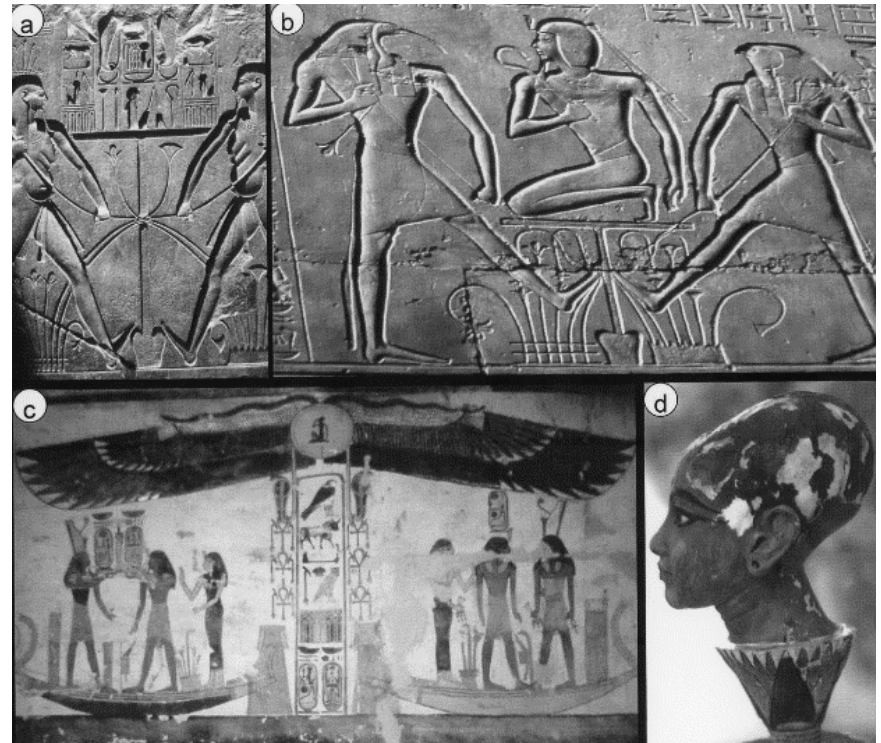
Figure 4. Union symbol (sema-taui) and ankh. ( a ) The cartouche of Ramesses II replaces a lotus flower on the central shaft of the sema-taui motif in Thebes. Twin gods (Hapy figures) that personify the floodwaters of the Nile River grasp the lotus and papyrus stems to support the axis mundi. Luxor, 13th c. BCE. ( b ) A kneeling image of Ramesses II replaces the sema-taui’s lotus blossom in Thebes. Karnak, 13th c. BCE. ( c ) A winged disk that rises on an aquatic column in the Tomb of Ramesses IX is clearly symbolic of a lotus blossom instead of a solar orb. Twin cartouches of Ramesses IX ascend the lotus stalk and transform themselves into the living image of the solar/floral structure, inside of which is observed the image of the resurrected king as Harpocrates (personified Horus). The